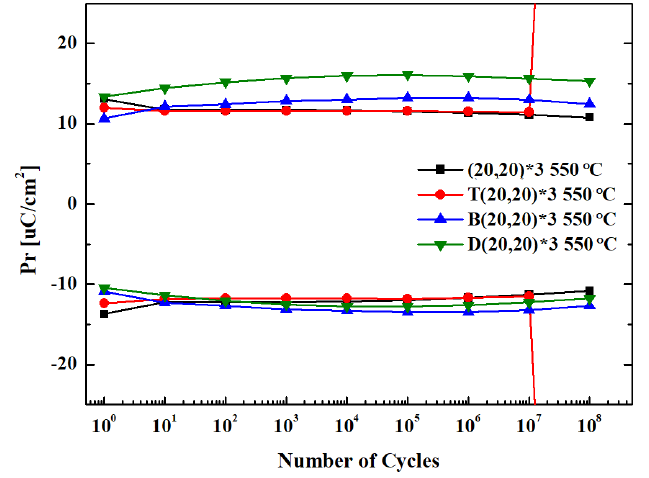
Figure 12. Fatigue endurance of the 550 ◦ C–RTA-treated specimens in the absence and presence of the seed layer.